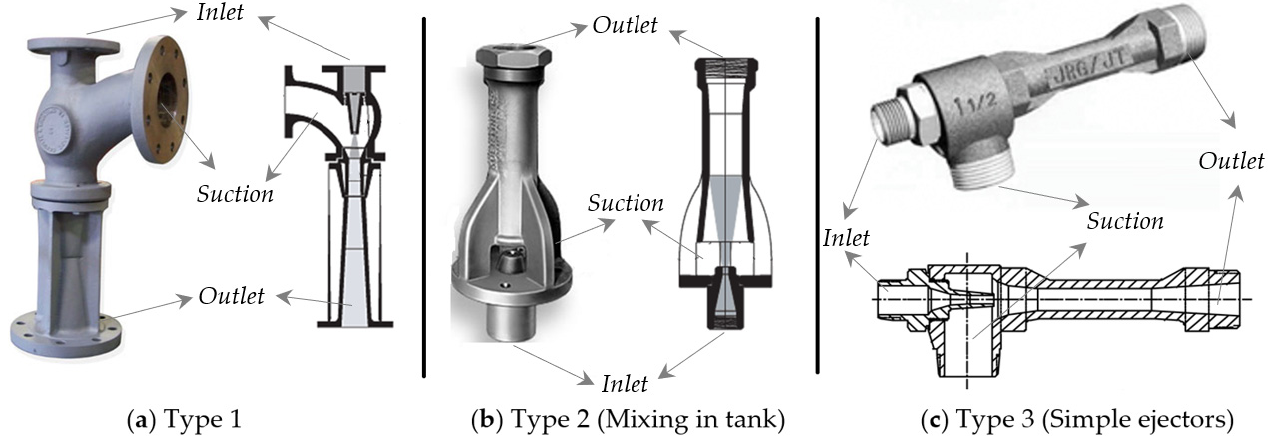
Figure 4. Commercial products available on the market [41–46].